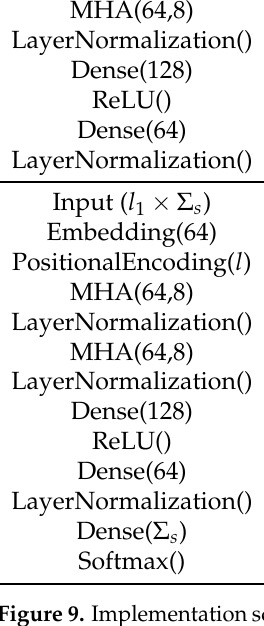
Figure 9. Implementation scheme of the transformer model, where MHA represents the multi-headed attention layers, which take as a first parameter their size and as a second parameter the number of heads that the attention matrix has to be split in. l represents the sample length; Σ a is the size of the agnostic vocabulary, even of not being a one-hot encoded input; and Σ s is the size of the semantic